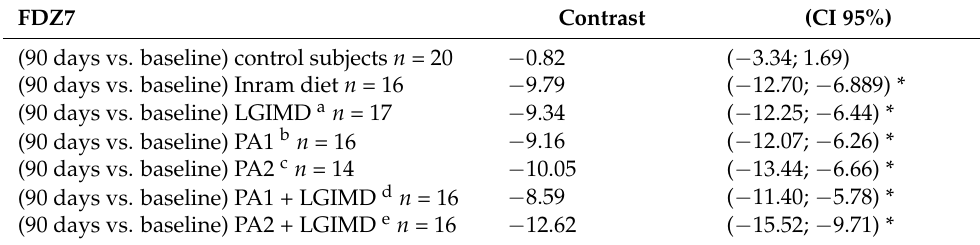
Table 5. Measures analysis of variance. Effect of treatments on FDZ7a expression. Contrasts by time. NutriAtt Trial, Castellana Grotte, 2015–2016 a FDZ7; a LGIMD: low glycemic index Mediterranean